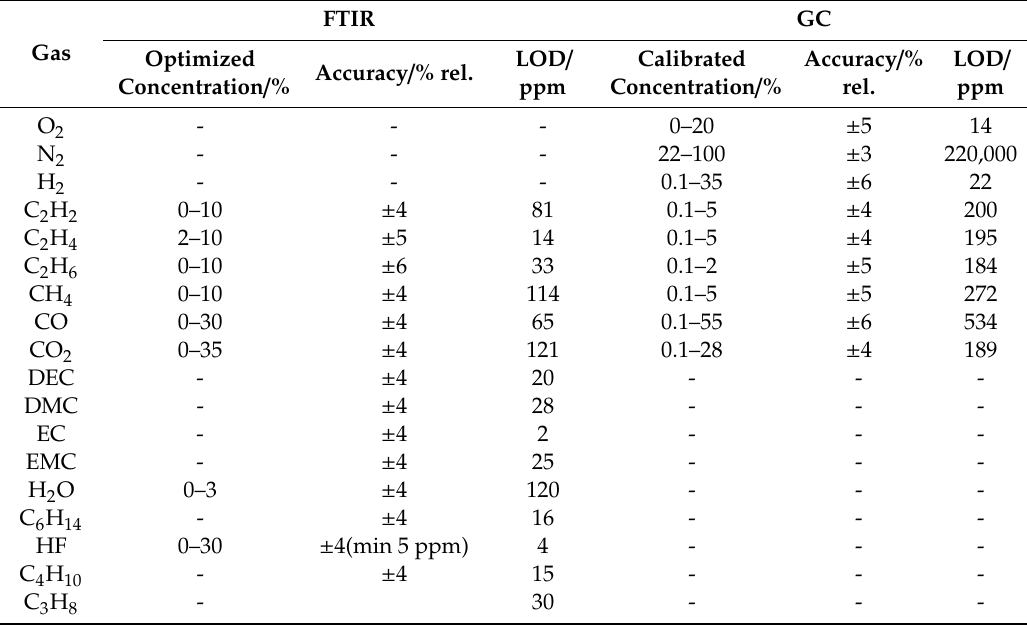
LOD: limit of detection at the specific setting in parts per million (ppm). -: not calibrated for quantitative analysis or not possible to